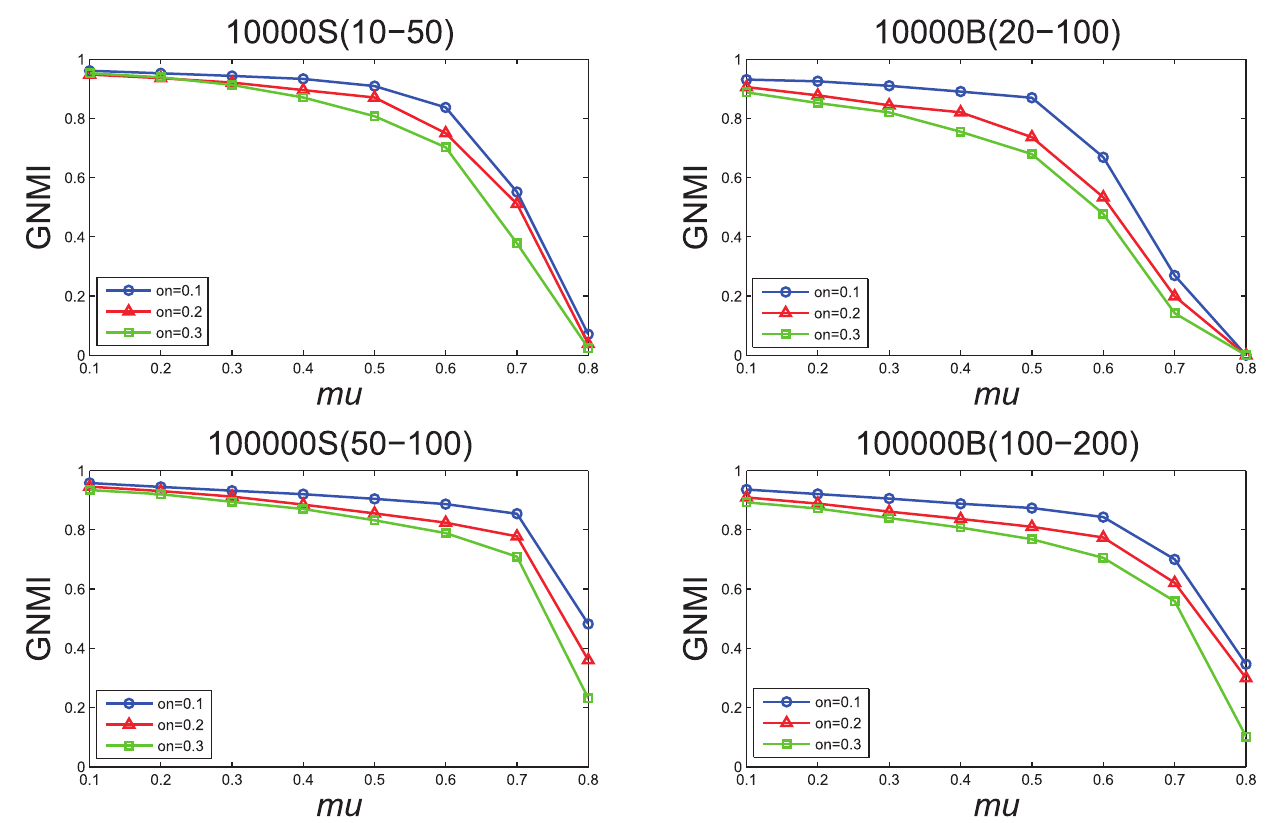
Figure 8. Test of the accuracy of our algorithm on LFR overlapping benchmark networks.